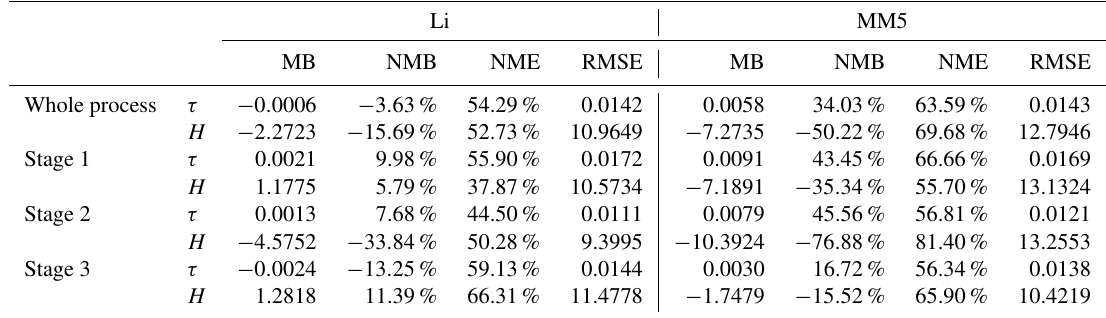
Table 2. Statistics between the Li and MM5 schemes of the calculated turbulent flux at Gucheng station.